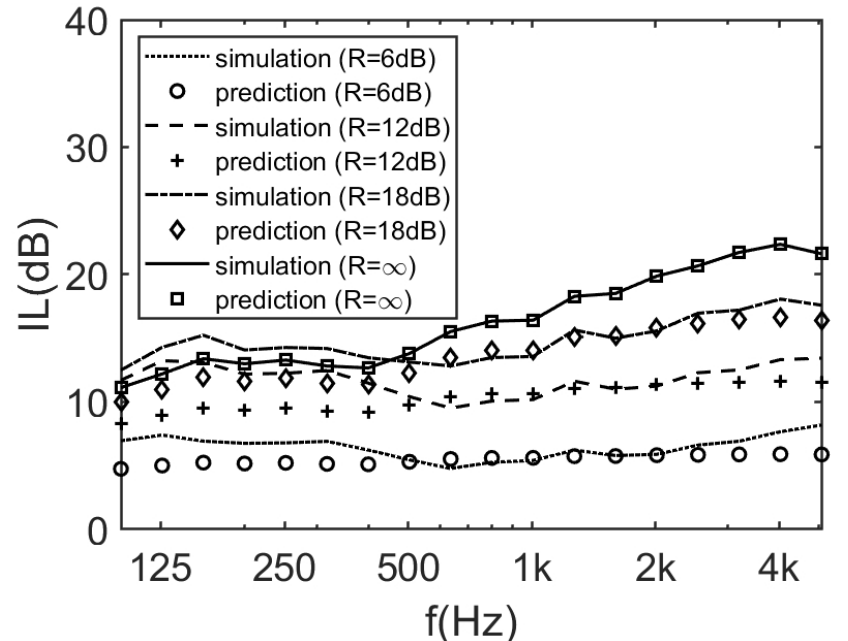
Figure 4. Values of IL index, predicted using the proposed simple model (Equation (5)) and simulated with the “modified FDTD” model, as a function of the frequency, for different values of noise reduction, R.